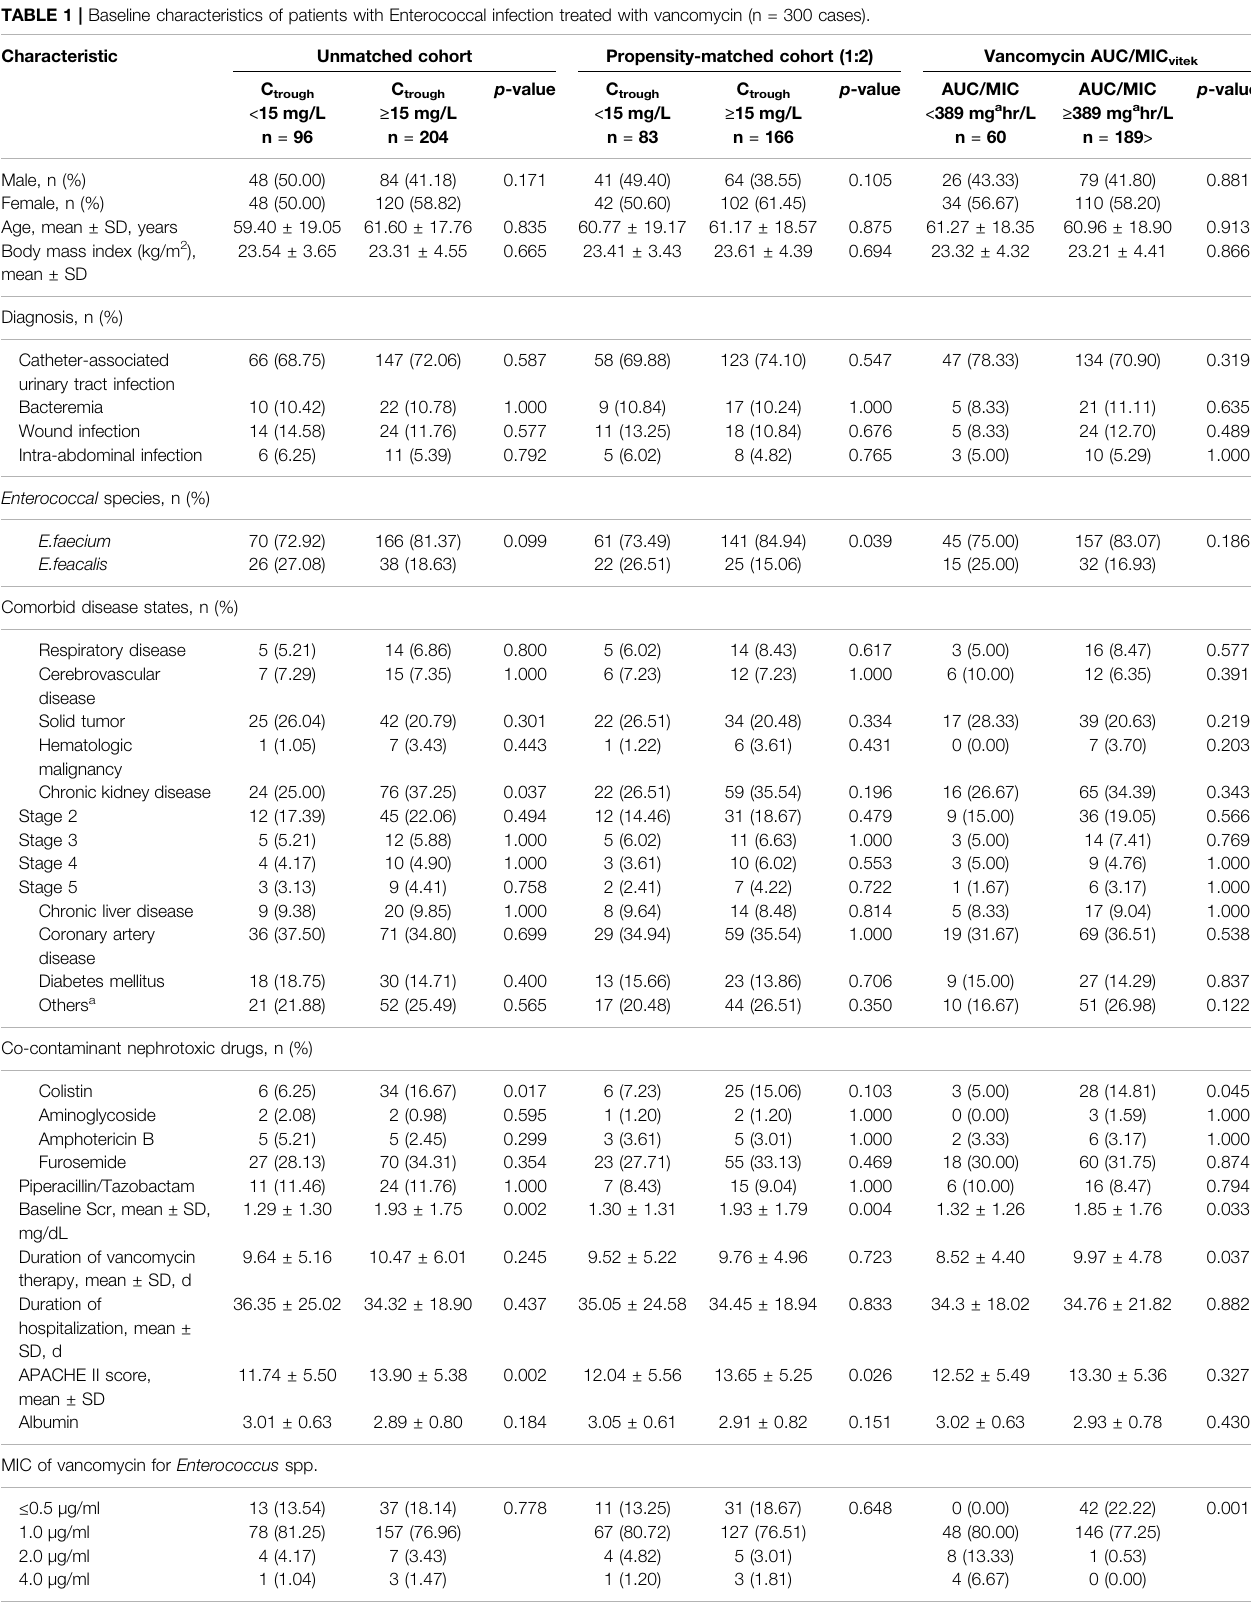
TABLE 1 | Baseline characteristics of patients with Enterococcal infection treated with vancomycin (n (cid:1) 300 cases).